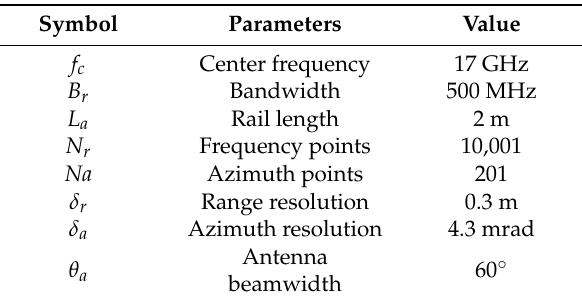
Table 1. System Table 1. System parameters.